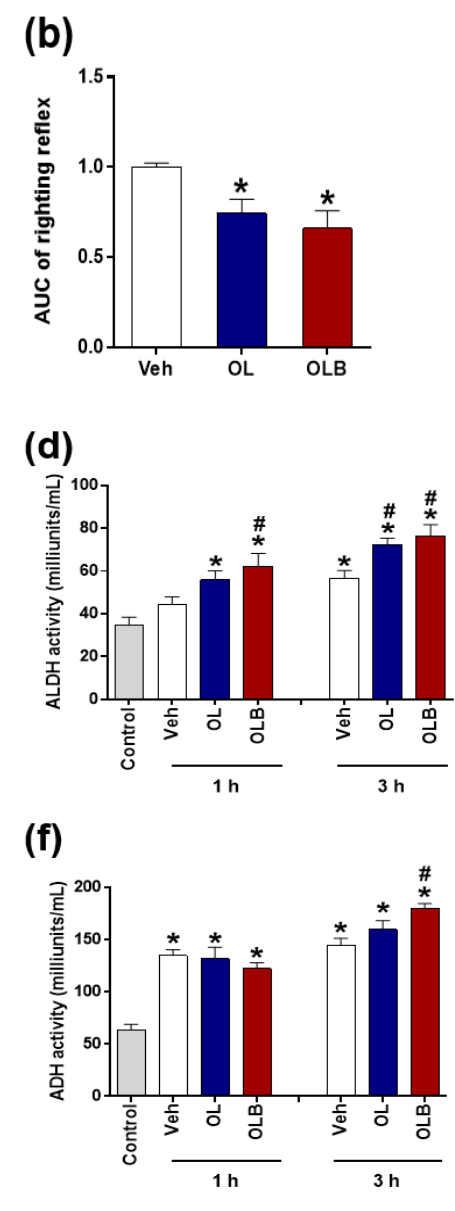
Figure 3. Effect of two extracts, oxidation-treated leaves (OL) and oxidation-treated leaves and branches (OLB), on alcohol tolerance time following acute ethanol-loading in mice. Mice were treated with water (Veh), OL, or OLB 1 h before injection of 4.5 g/kg ethanol ( n = 6, respectively). Loss of stereotactic reflexes was monitored for 80 min, scores of behavioral changes were plotted over time ( a ), and the area under the curve (AUC) was calculated ( b ). Blood ethanol ( c ) and acetaldehyde ( e ) levels were measured. OL and OLB decreased blood ethanol and acetaldehyde concentrations in ethanol-injected rats. Mice were treated with water, OL, or OLB 1 h before 1.5 g/kg ( c – f ) ethanol injection ( n = 8, respectively), and blood was collected 1 and 3 h later. As a control group, an untreated treatment group ( n = 5) was included. In ethanol-injected mice, OLB increased the activity of ethanol-metabolizing enzymes. Hepatic activity of alcohol dehydrogenase (ADH) and aldehyde dehydrogenase (ALDH) in liver tissue was measured 1 and 3 h after ethanol injection ( d , f ). Data are presented as the means ± SEM. * p < 0.05 versus control, # p < 0.05 versus Veh; ## p < 0.01 versus Veh.